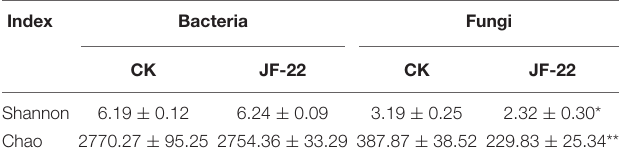
TABLE 4 | Diversity and richness indices of microbial communities from the CK and JF-22 experimental